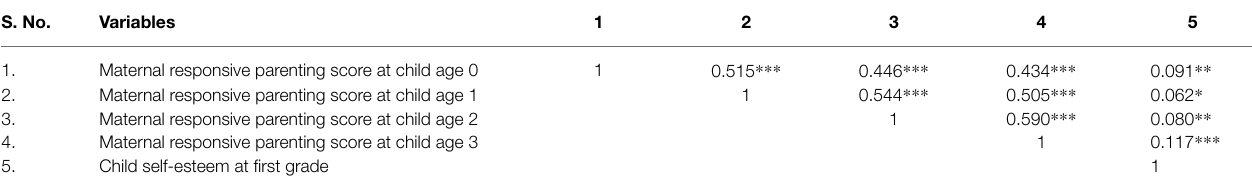
TABLE 4 | Correlations between maternal responsive parenting scores from birth to age 3 and child self-esteem at first grade ( n = 1,560). S.